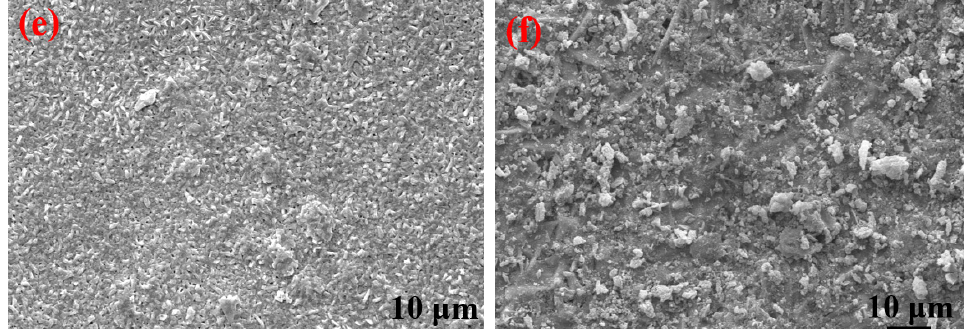
Figure 5. SEM images of corrosion products on the surfaces of S135 and G105 samples at different temperatures: ( a ) S135, room temperature; ( b ) G105, room temperature; ( c ) S135, 100 °C; ( d ) G105,